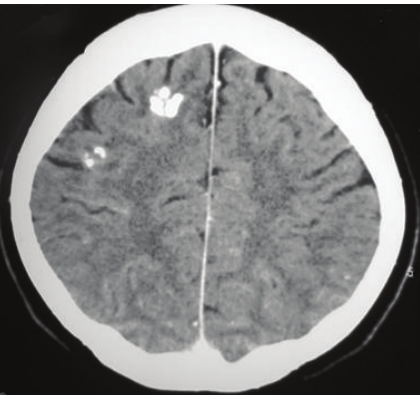
Figure 6: Treated tuberculoma. Axial noncontrast CT image shows two calcified lesions in right frontal lobe without edema or mass effect.